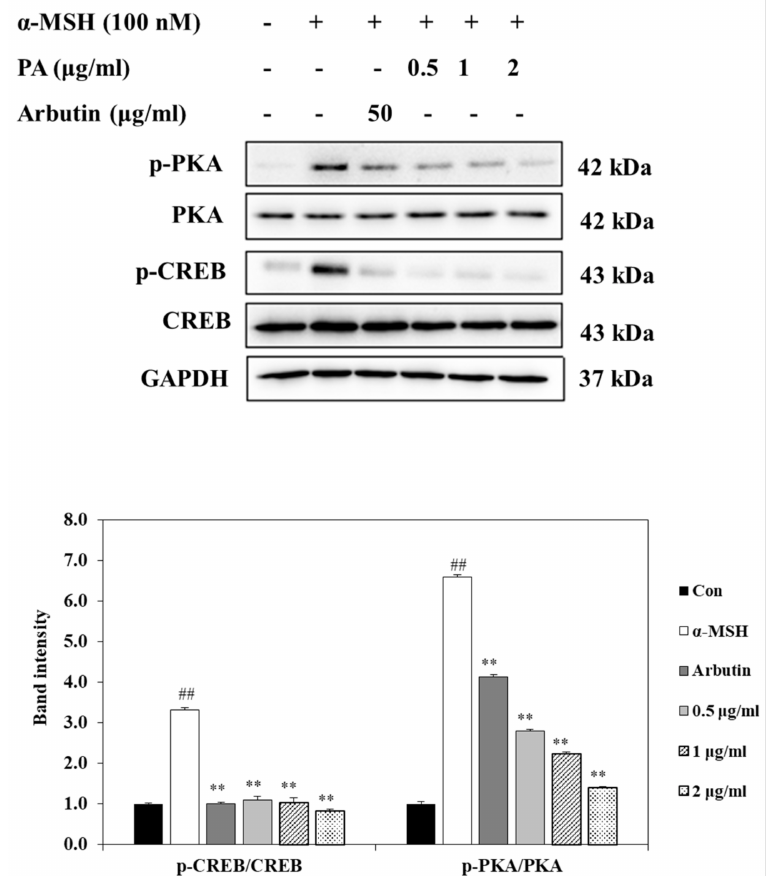
Figure 4. PA suppresses the PKA and CREB signaling pathways in α -MSH-stimulated B16F10 cells. Cells were exposed to 100 nM α -MSH in the presence of PA at the indicated concentrations or 50 µ g/mL arbutin. The protein expression levels of p-PKA/PKA and p-CREB/CREB were determined using Western blot analysis and quantified using Image J. Values are expressed as means ± SDs of triplicate experiments ( n = 3). Note: ## p < 0.01 compared to the untreated control group; ** p < 0.01 compared to α -MSH